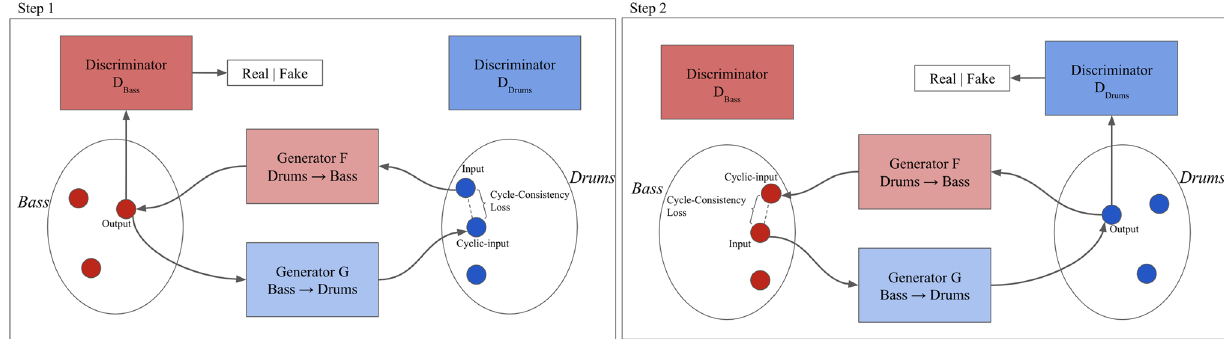
Fig. 2 CycleGAN is a framework designed to translate between domains with unpaired input–output examples. The architecture assumes some underlying relationship between domains and tries to learn it. In our case, based on a set of bass images in the domain X and a set of drum images in the domain Y , the algorithm jointly learns a mapping G ∶ X → Y —from bass to drums—and a mapping F ∶ Y → X —from drums to bass, such that the output ̂ y = G ( x ) for every x ∈ X is indistinguishable from images y ∈ Y , and ̂ x = G ( y ) for every y ∈ Y is indis- tinguishable from images x ∈ X . Given a mapping G ∶ X → Y and another mapping F ∶ Y → X , then G and F should be one the inverse of the other, and both mappings should be bijections. This property is achieved by training both the mapping G and F simultaneously and by adding a cycle-consistency loss that encourages F ( G ( x )) ≈ x and G ( F ( y )) ≈ y . Finally, the cycle-consistency loss is combined with the adver- sarial losses on domains X and Y